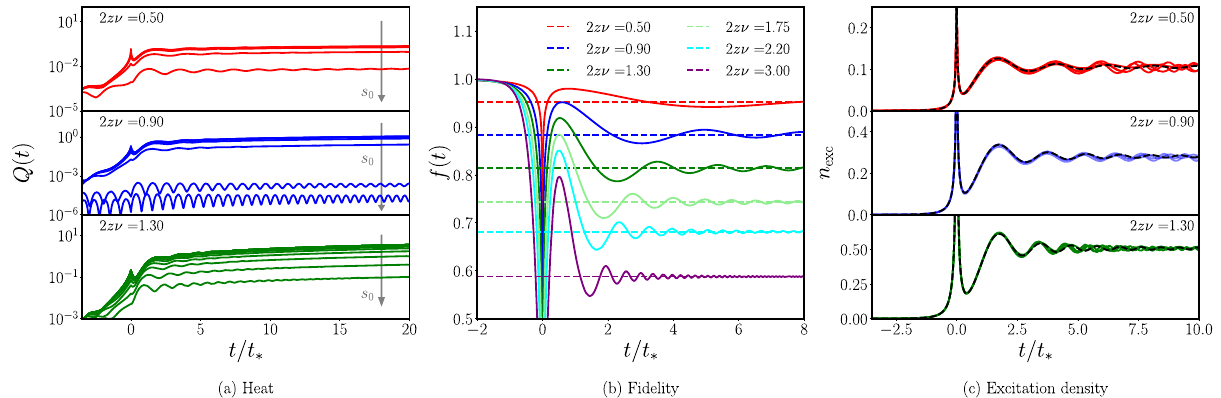
(cid:1) (cid:3) 2 z ν , with minimal s ¼ δ (cid:2) 1 = ð 1 þ z ν Þ ω 1 = z ν . The values of s 0 ∈ [0, 10] grow in the 0 0